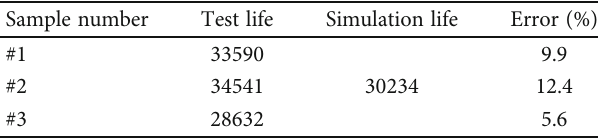
Figure 14: FEM modeling and crack surface Table 2: Comparison of test and simulation life.